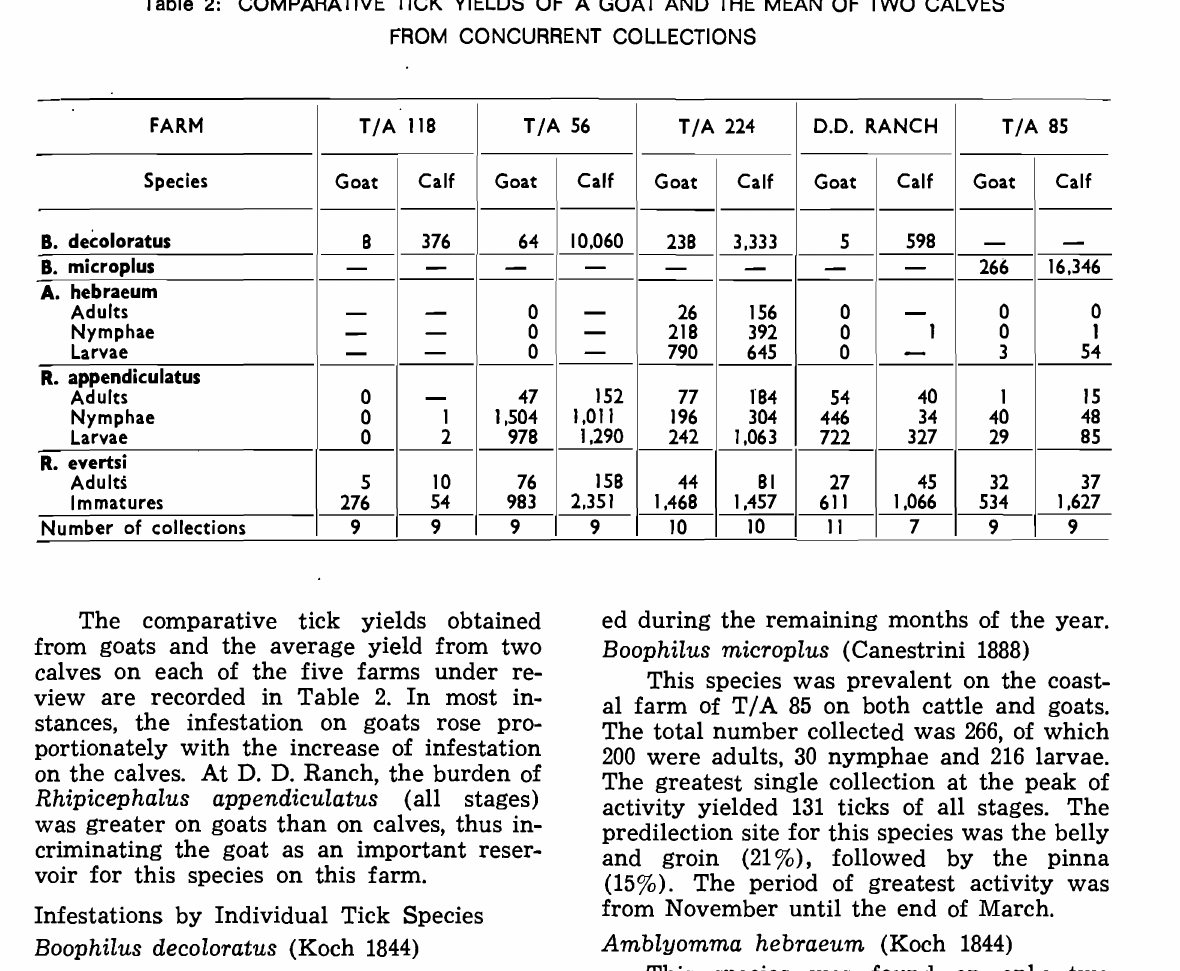
Table 2: COMPARATIVE TICK YIELDS OF A GOAT AND THE MEAN OF TWO CALVES FROM CONCURRENT COLLECTIONS